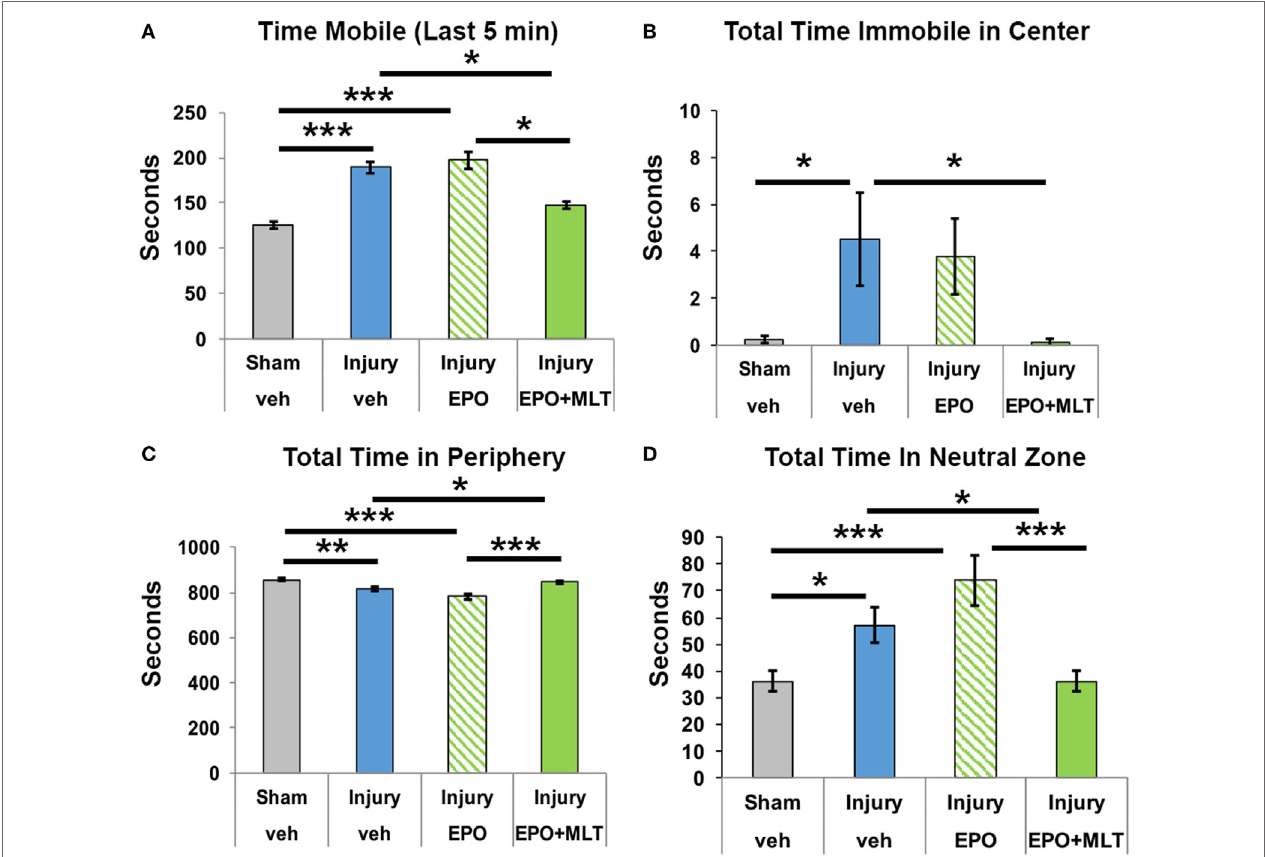
FigUre 1 | Open field testing of locomotion and disinhibition. (a) After prenatal injury, vehicle-treated rats are more mobile than shams, particularly in the last 5 min interval. Erythropoietin (EPO) + melatonin (MLT), but not EPO alone, normalizes the activity. (B) Rats typically avoid open areas. Vehicle-treated adult rats following prenatal injury spend more time immobile in the center zone than sham rats or EPO + MLT-treated rats. (c) Sham and EPO + MLT-treated injured rats spent more time in the peripheral zone than vehicle-treated or EPO-treated injured rats. (D) Similarly, vehicle-treated injured rats spent more time in the neutral zone than sham or EPO + MLT-treated rats. EPO treatment by itself did not improve disinhibition (two-way ANOVA with Bonferroni correction, * p < 0.05, ** p < 0.01, *** p <